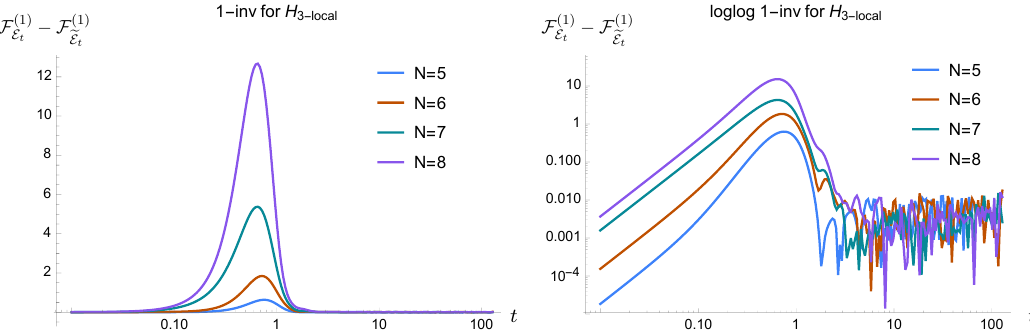
Figure 6 . We plot the distance to 1-invariance, the difference between the first frame potential and the unitarily invariant frame potential, for the random 3-local model with N = 5 , 6 , 7 and 8 spins and observe the decay to approximate 1-invariance at late